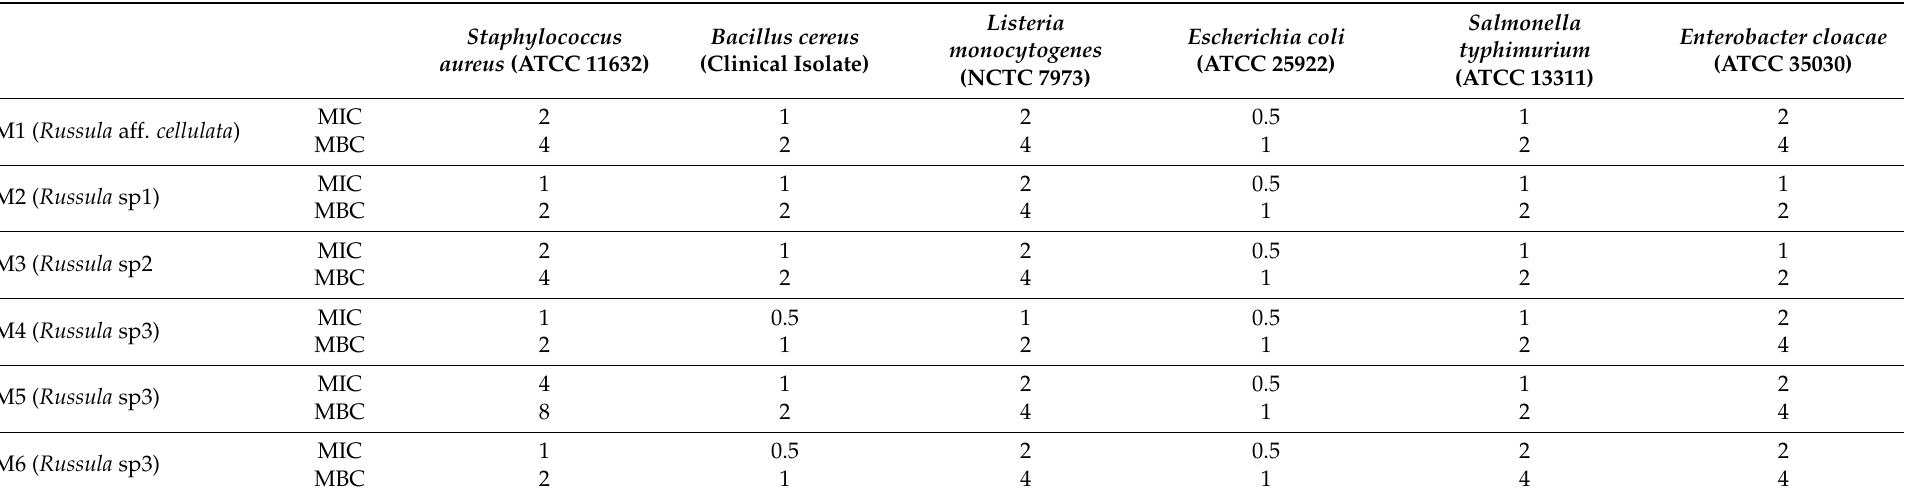
Table 4. Antibacterial activity of the studied mushroom hydroethanolic extracts